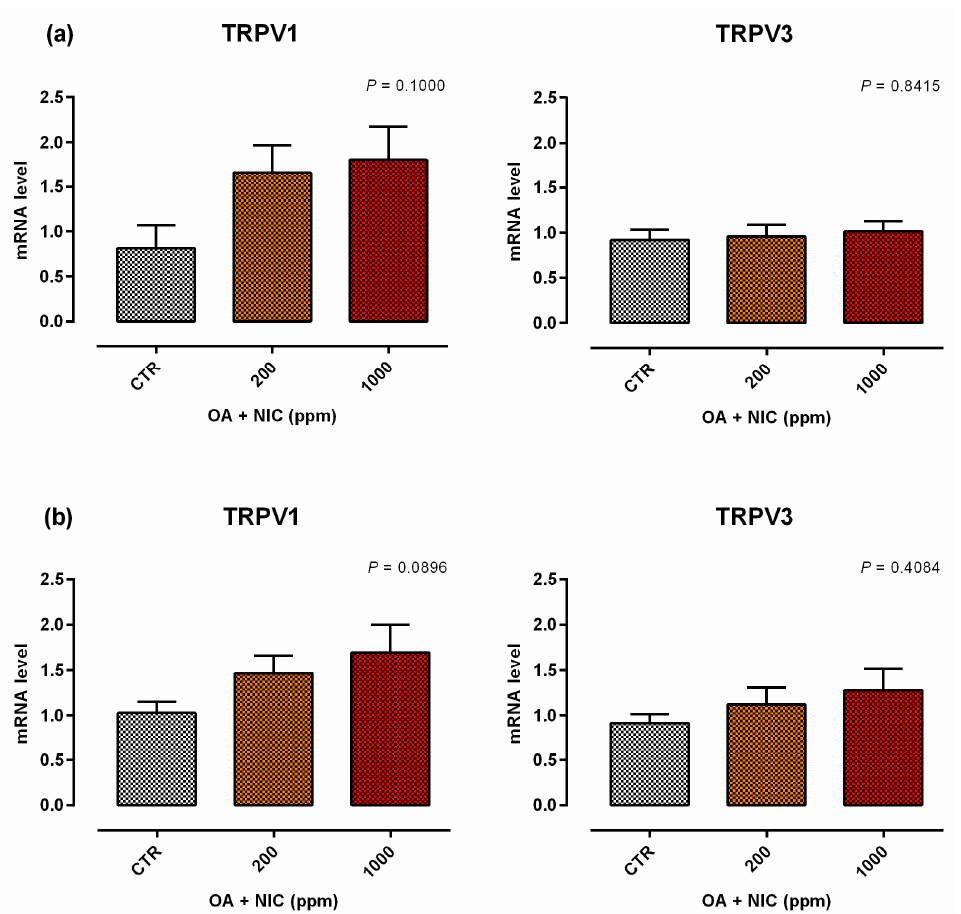
Figure 11. Gene expression in Caco-2 cells after 15 days of treatment with OA + NIC and subjected to an inflammatory challenge. Values are least square means ( n = 6) ± SEM represented by vertical bars. A modification of the 2 – ΔΔ CT method [16] was used to analyze the relative expression (fold changes), calculated relative to the control group. Means with different letters indicate statistical significance with p < 0.05 (a, b); means with at least one common letter are not significantly different (ab). CTR = control group; OA + NIC 200 = treated group with 200 ppm of OA + NIC, composed by 260 µM of citric acid, 298 µM of sorbic acid, 23 µM of thymol, and 13 µM of vanillin; OA + NIC 1000 = treated group with 1000 ppm of OA + NIC, composed by 1300 µM of citric acid, 1490 µM of sorbic acid, 110 µM of thymol, and 70 µM of vanillin; TRPV1 = Transient Receptor Potential Vanilloid 1; TRPV3 = Transient Receptor Potential Vanilloid 3. ( a ) Cells challenged at day 0 of the study. ( b ) Cell challenged at day 14 of the study.